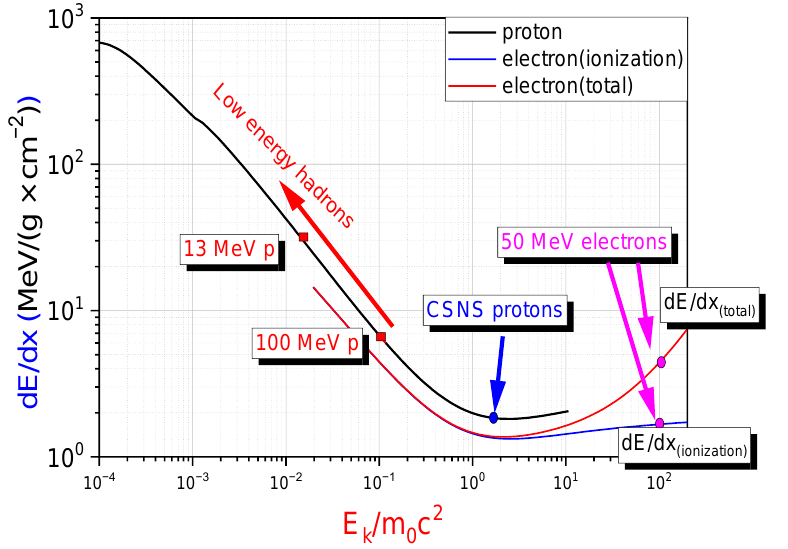
Figure 2. The specific energy loss of different particles with different energies in the matter.